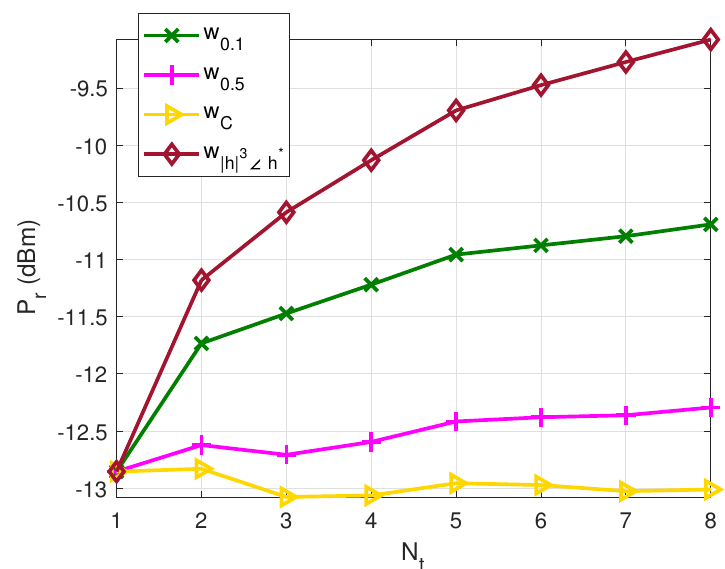
Figure 15. Received power as a function of the number of tones using the proposed pre-equalizers in a multisine SWIPT, ρ = 0.5, B = 1